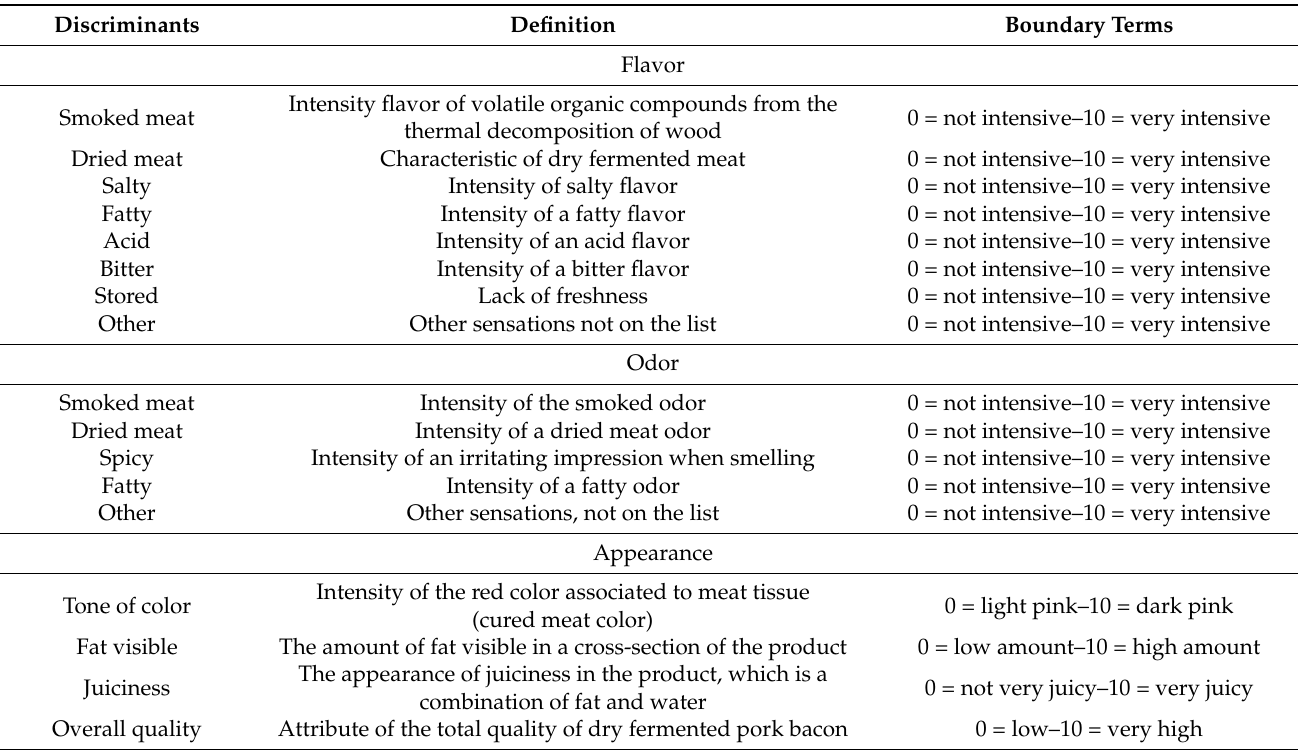
Table 1. Definition of the sensory